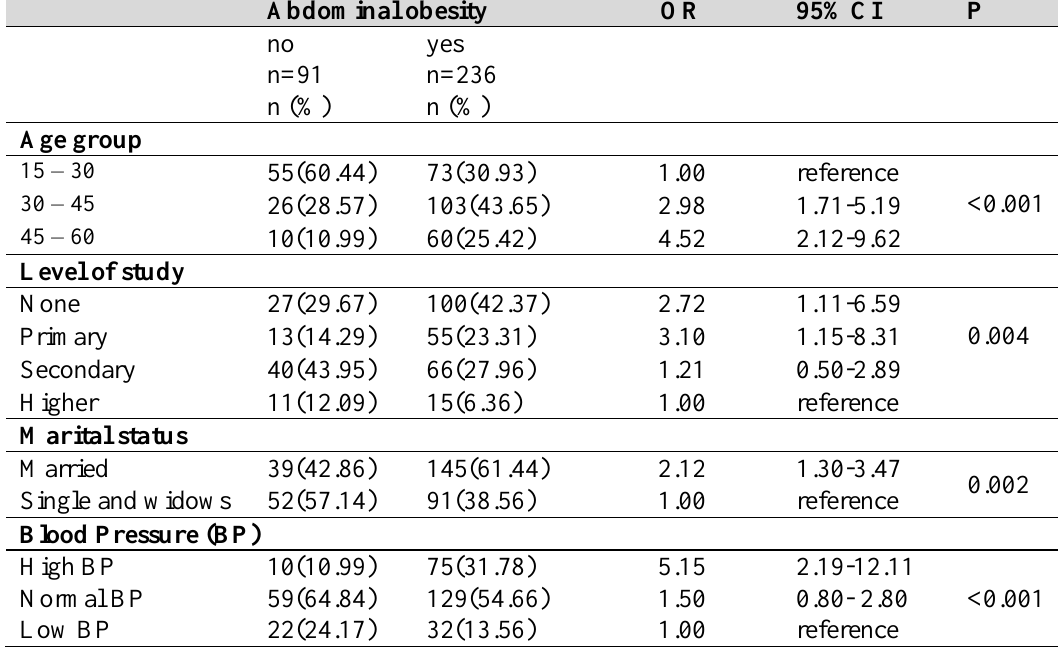
Table 3. Association between abdominal obesity among women (n=327) and the analyzed different factors in Anonkoi